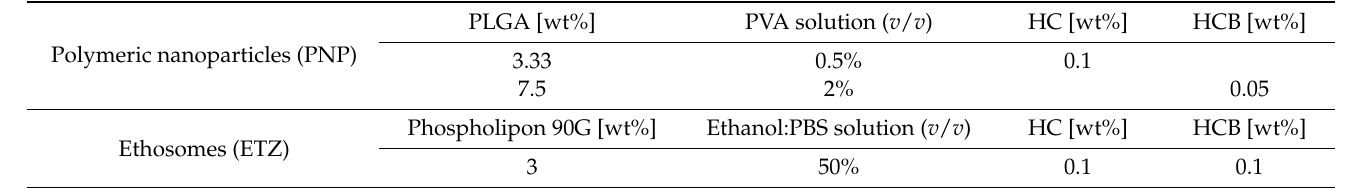
Table 3. The composition of polymeric nanoparticles and ethosomes prepared for topical delivery of hydrocortisone (HC) and hydrocortisone-17-butyrate